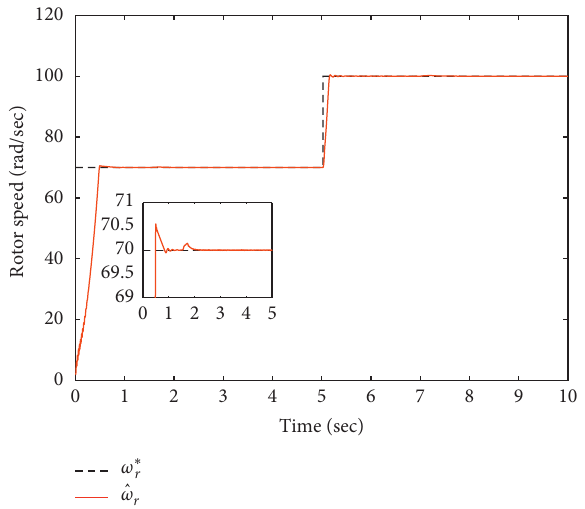
Figure 14: Evolution of output—predictive controller (noisy measurements).